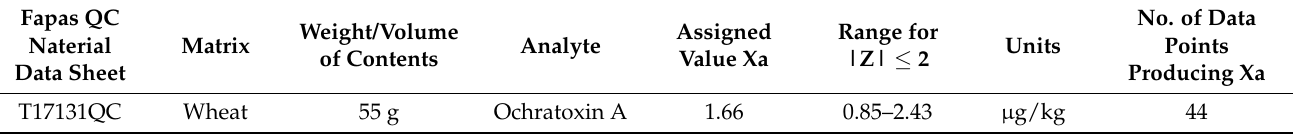
Table A2. The FAPAS Quality Control Naterial Data